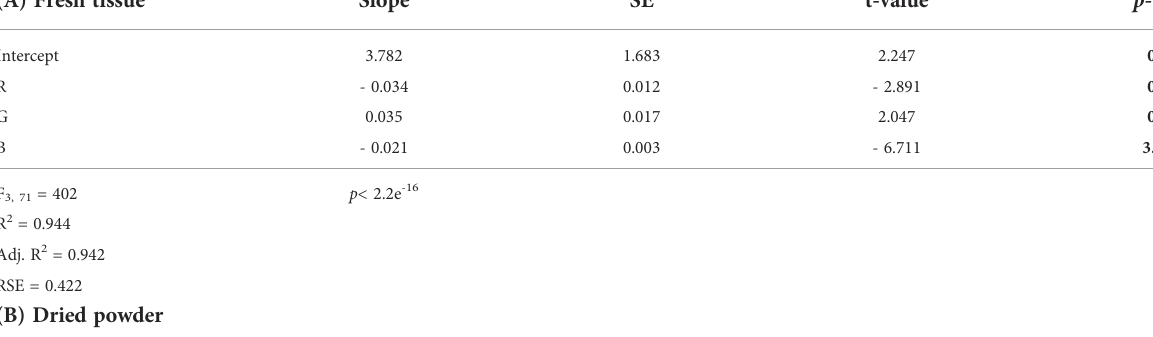
TABLE 1 Output from the multiple linear regression models for nitrogen content as a function of the independent color variables R + G + B for (A) fresh tissue and (B) dried powder of Ulva fenestrata. (A) Fresh tissue